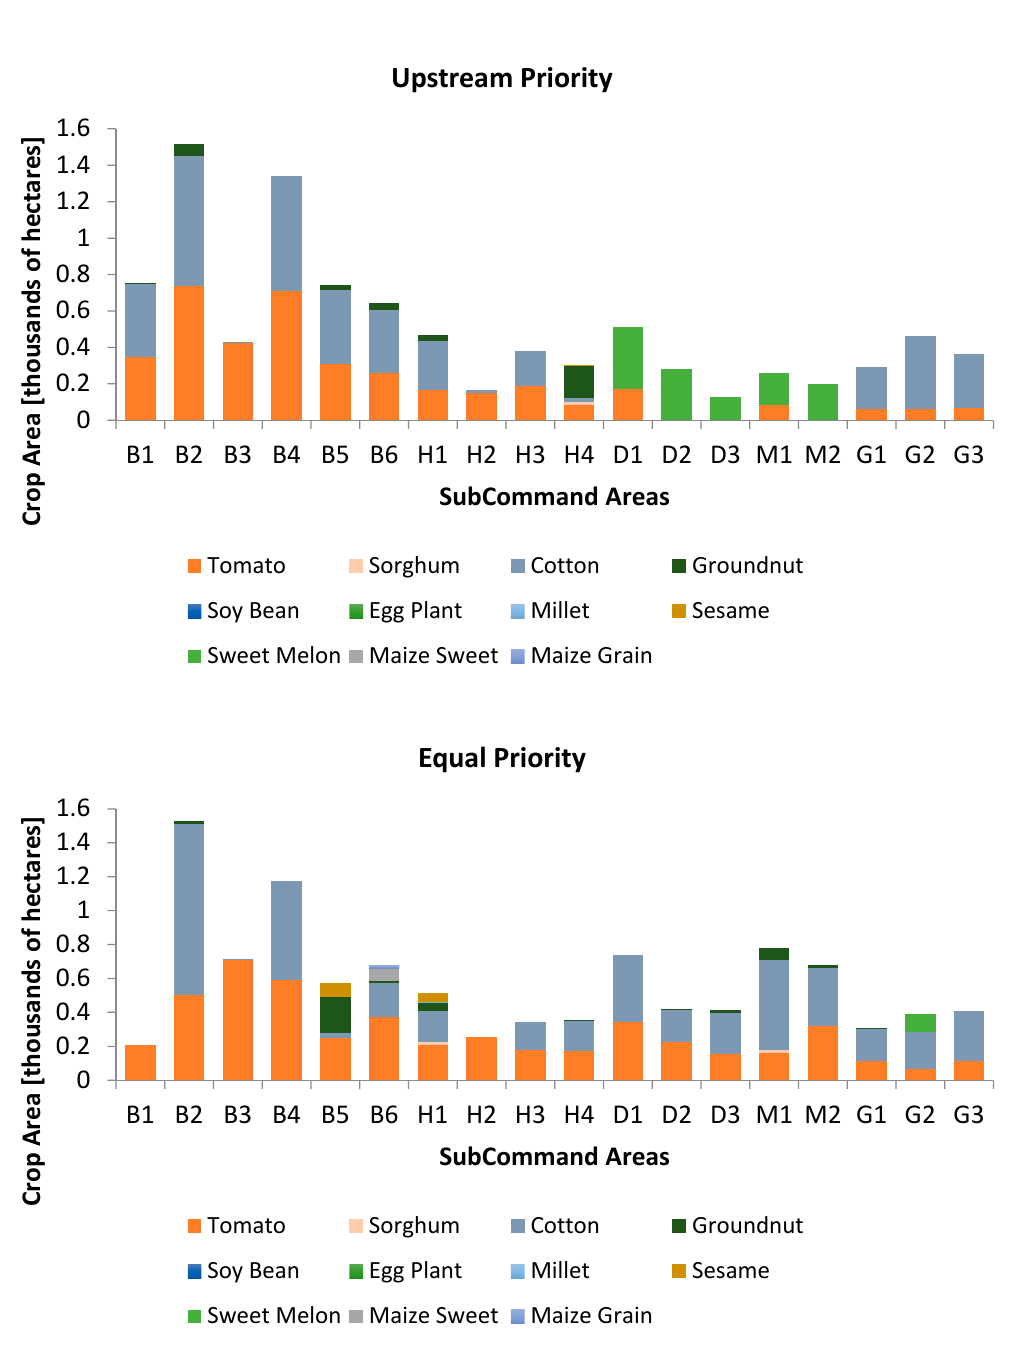
Figure 6. Comparison of crop diversity and cropping area for each command area using the upstream and equal allocation scenarios.